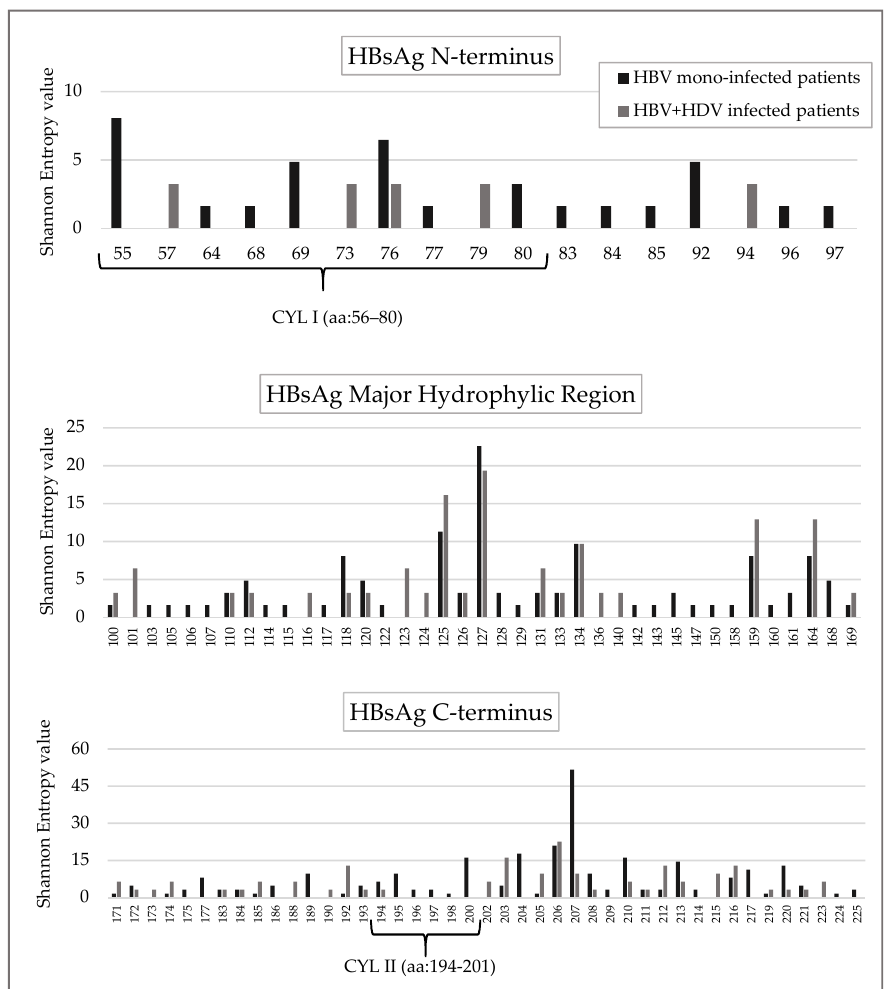
Figure 3. The histogram reports the Shannon Entropy (Sn) value at HBsAg positions in HBV mono-infected patients (black bars) and HBV + HDV infected patients (grey bars). Conserved positions (Sn = 0) in both HBV + HDV infected and HBV mono-infected patients were not reported in the histogram. Shannon Entropy was calculated according to the following formula Sn = − Σ i(pi lnpi)/lnN) where pi was the relative frequency of each distinct amino acid detected at a given position and n was the total number of sequences